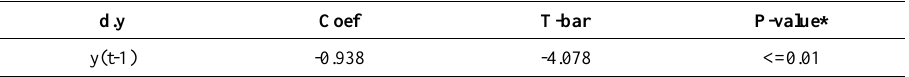
Table 3. Gengenbach, Urbain & Westerlund Panel EC Cointegration